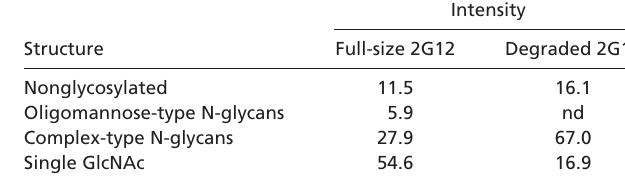
Table 2. Q-TOF analysis of tryptic glycopeptides from the purified, assembled 2G12 antibody isolated from maize seed endosperm and the 40-kDa degradation product